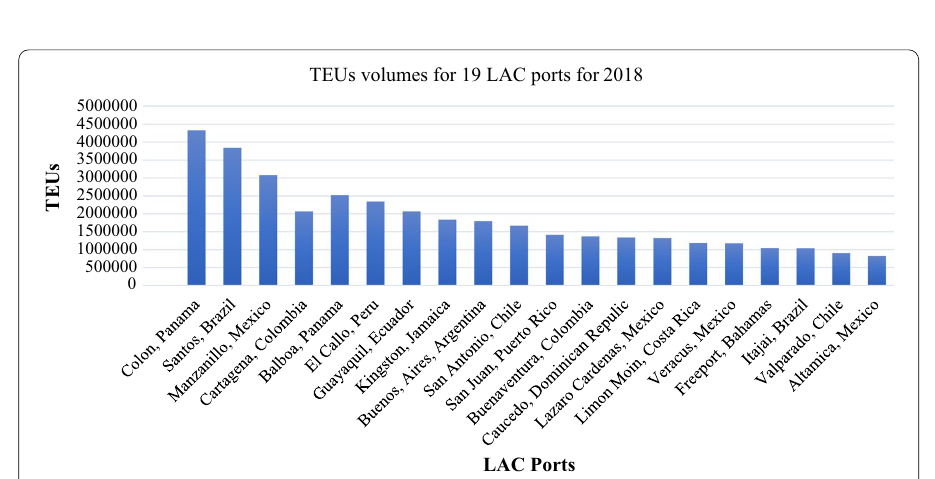
Fig. 3 Container through for 2018 for the Nineteen (19) LAC ports. Source : World Bank